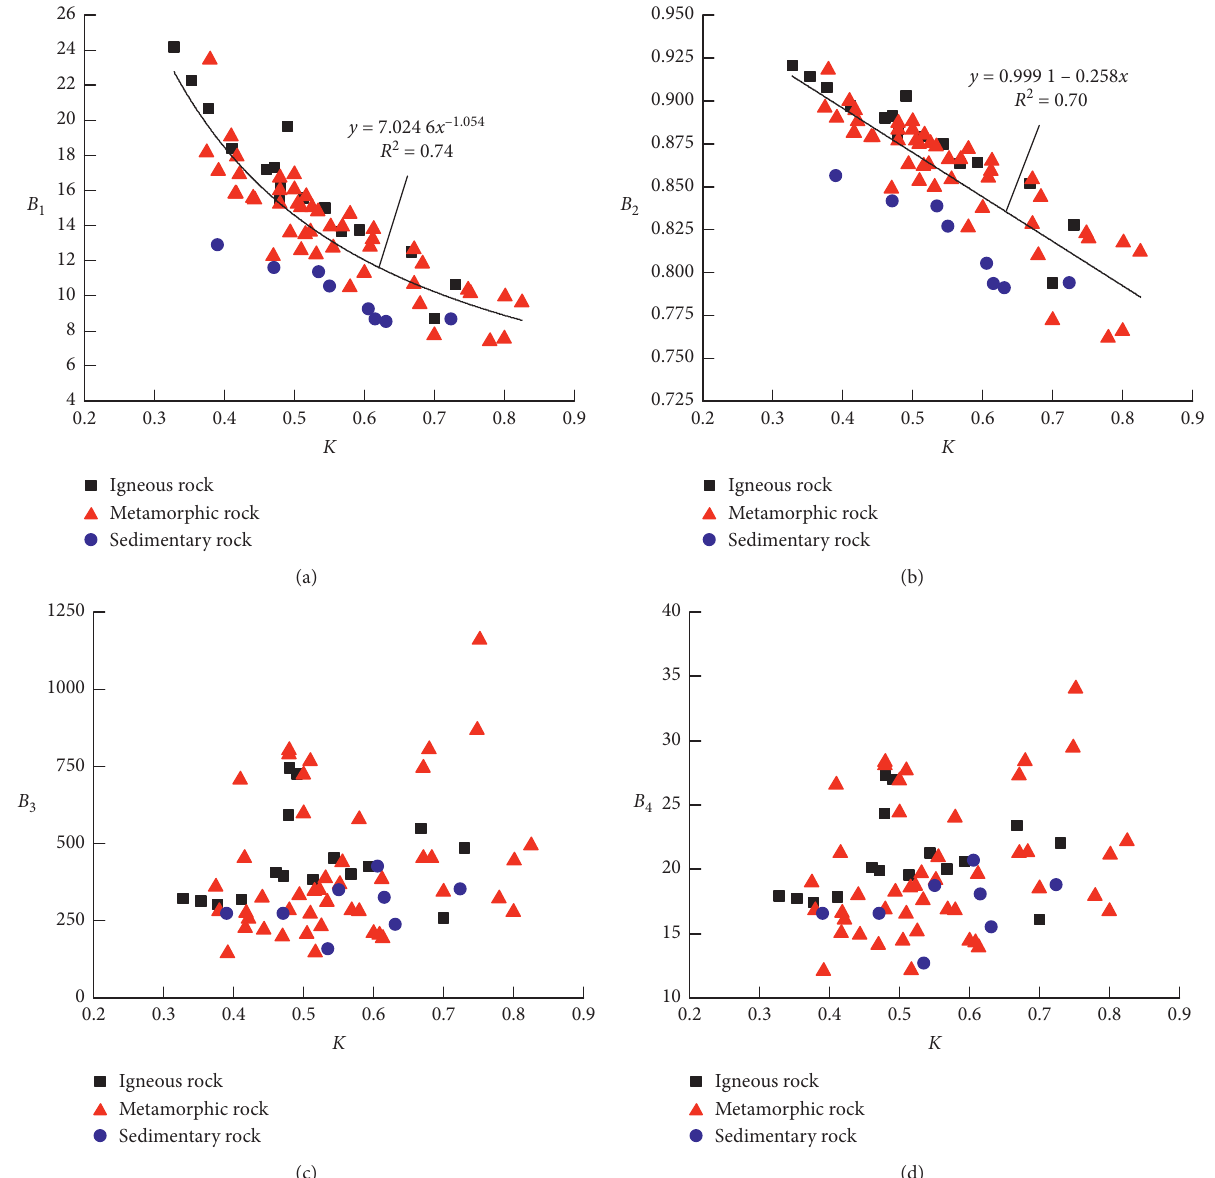
Figure 6: Relationship between crack initiation stress ratio K and different rock types of rocks with different brittleness indexes: (a) B B 2 ; (c) B 3 ; (d) B 4